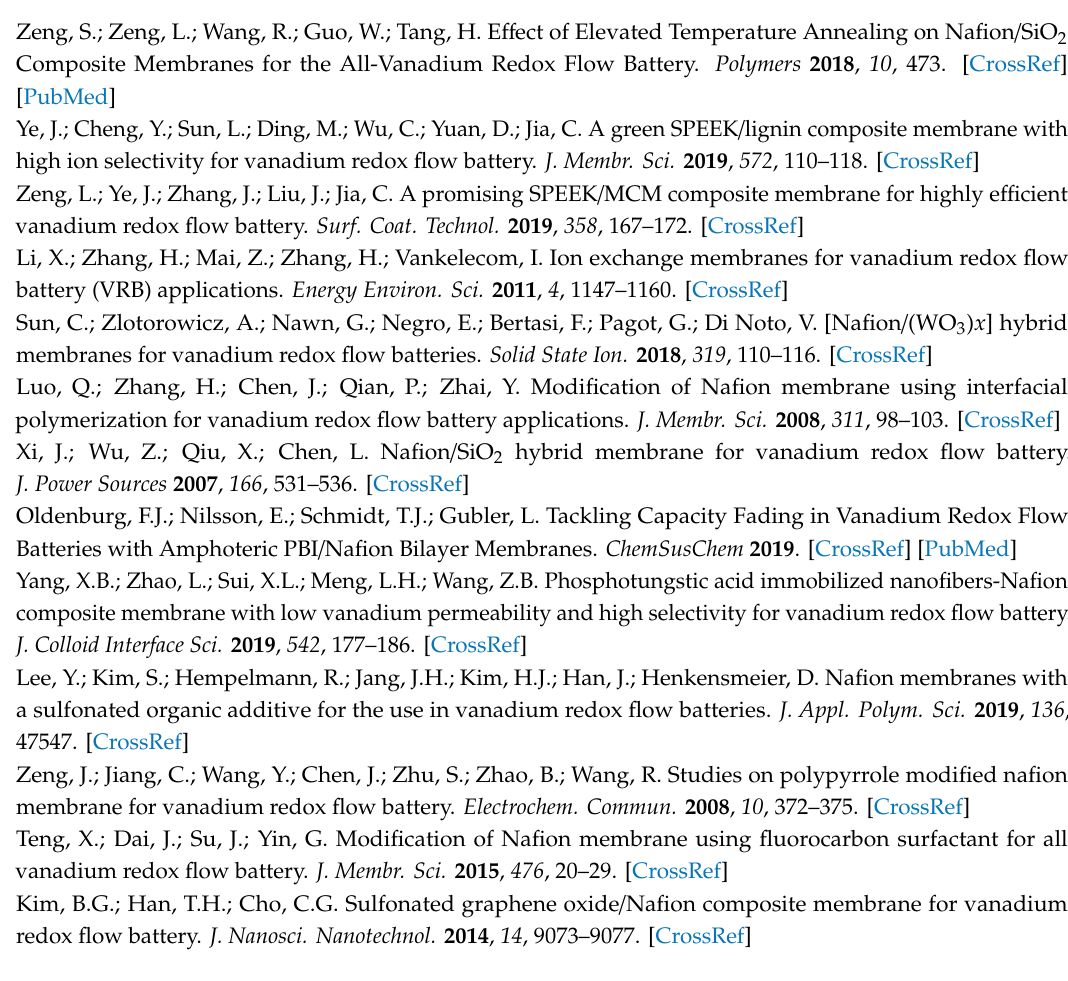
Figure S1: 1H NMR spectra of original EVOH and grafted EVOH powder (GY = 15.2%). Figure S2: XRD patterns of original EVOH and AIEM (GY =